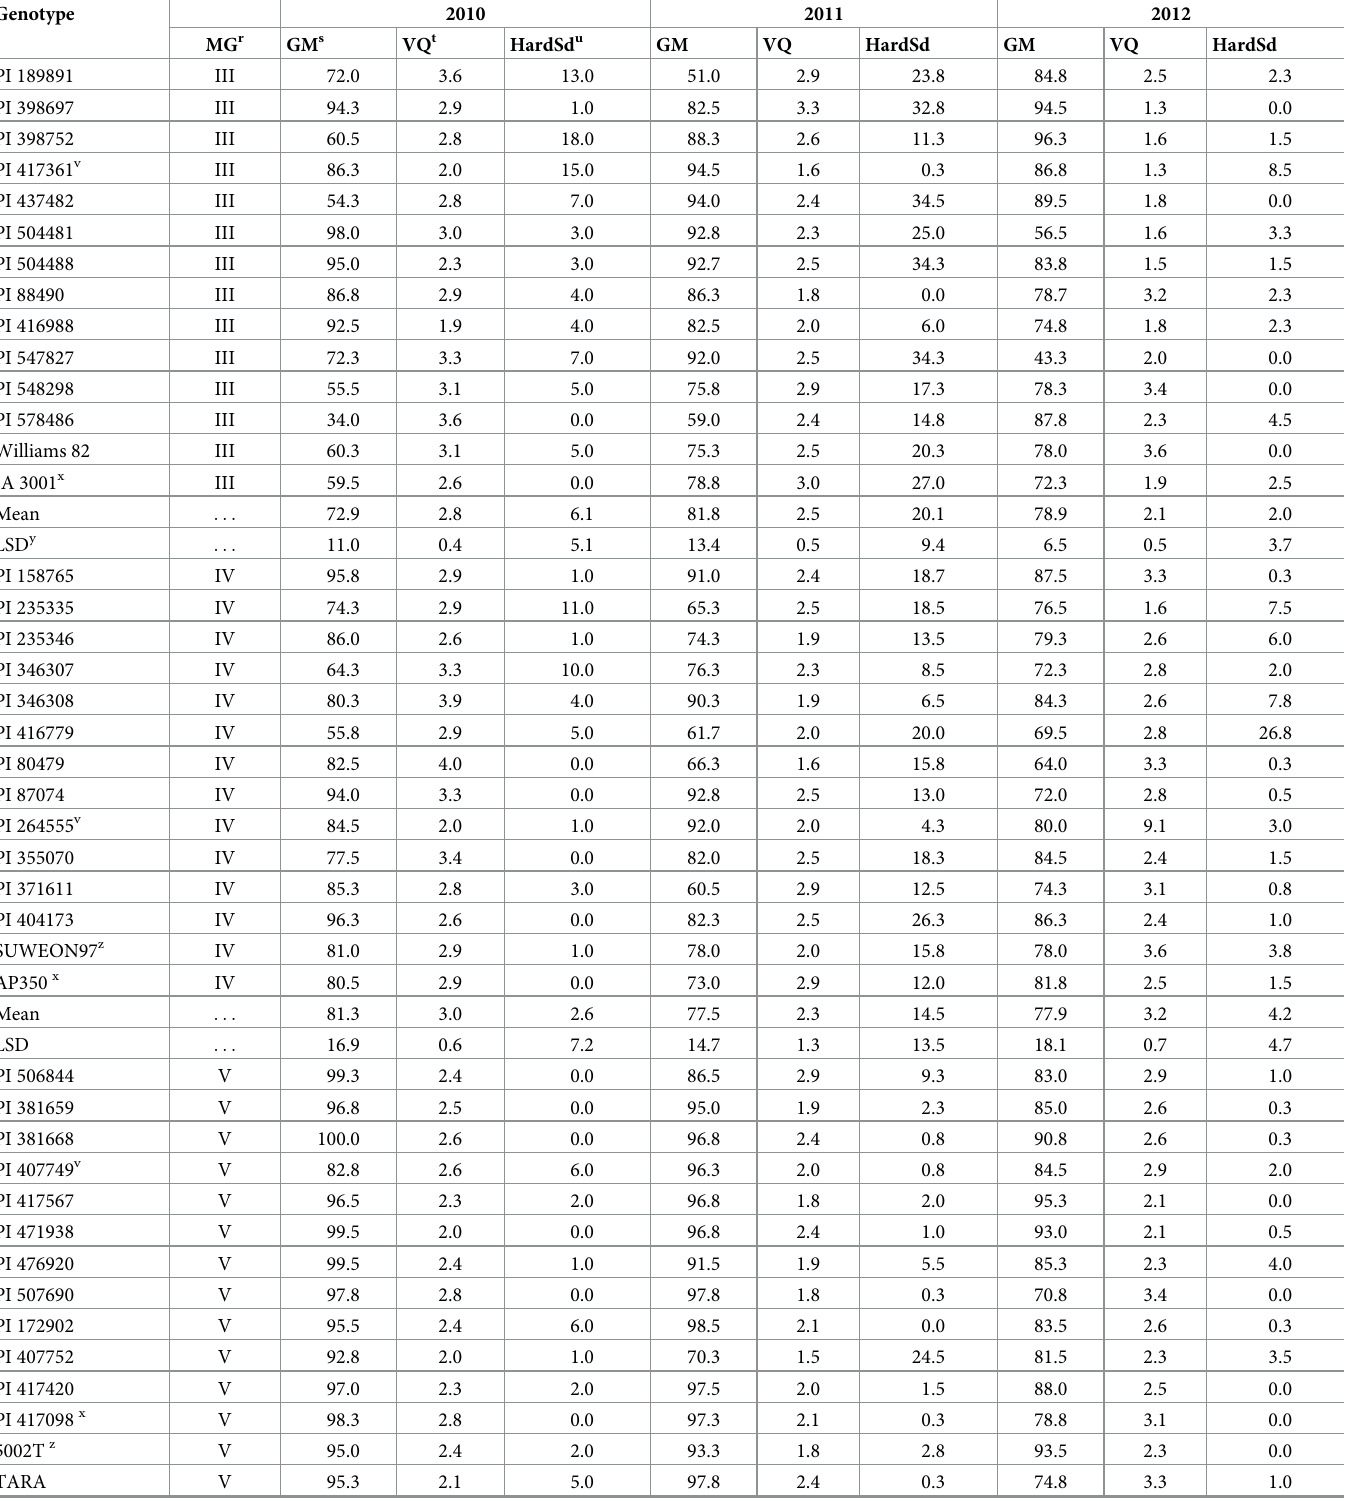
Table 5. Means of germination, visual quality, and hard seed of soybean genotypes in replicated field tests in Stoneville, Mississippi, during 2010–2012.